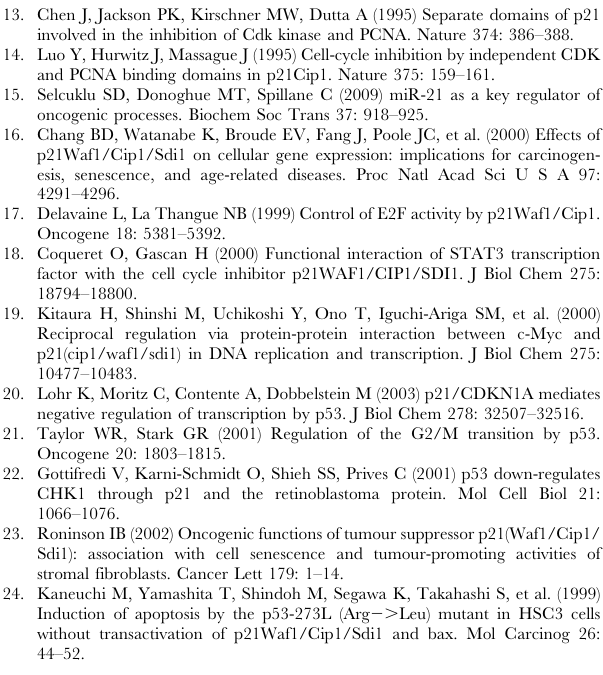
Figure S1 miR-21 levels in patients having low expression ( , 1.2): Low levels of miR-21 in patients with 100% survival. (TIF) Figure S2 miR-21 levels in patients having high expression ( . 1.2): High levels of miR-21 in patients with 50% survival. (TIF) Figure S3 Expression levels of miR-21 after knockdown in A- 498 cells: The miR-21 level was reduced by more than 99% (1.0 to 0.030), as compared to the negative control. (TIF) Figure S4 Expression levels of miR-21 after knockdown in Caki- 2 cells: The miR-21 level was reduced by more than 99% (1.0 to 0.011), as compared to the negative control.